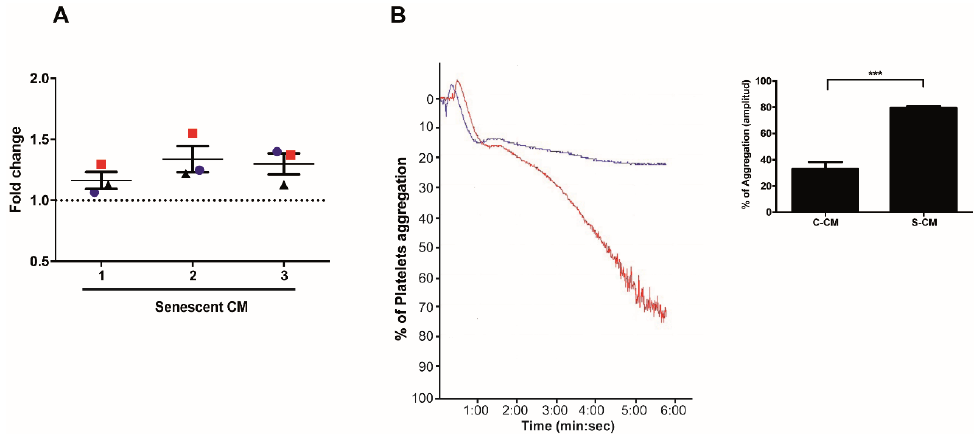
Figure 3. Effects of media conditioned by senescent cells on platelet aggregation and adhesion. ( A ) Adhesion (assessed under static conditions) of platelets exposed to media conditioned by senescent in the presence of media conditioned by senescent cells; the basal, discontinuous, line represents the basal adhesion of platelets exposed to media conditioned by non-senescent cells. Three donors were tested (red squares, blue circles and black triangles) with conditioned media. ( B ) Representative images incubated with conditioned media collected from senescent (blue curve) and non-senescent (red